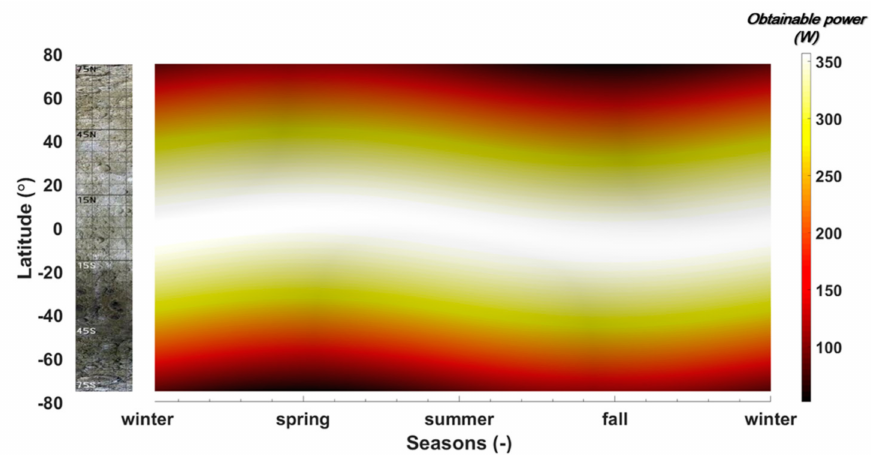
Figure 22. Solar energy map for a 1 m 2 solar panel with η = 27%, as a function of latitude and season on the